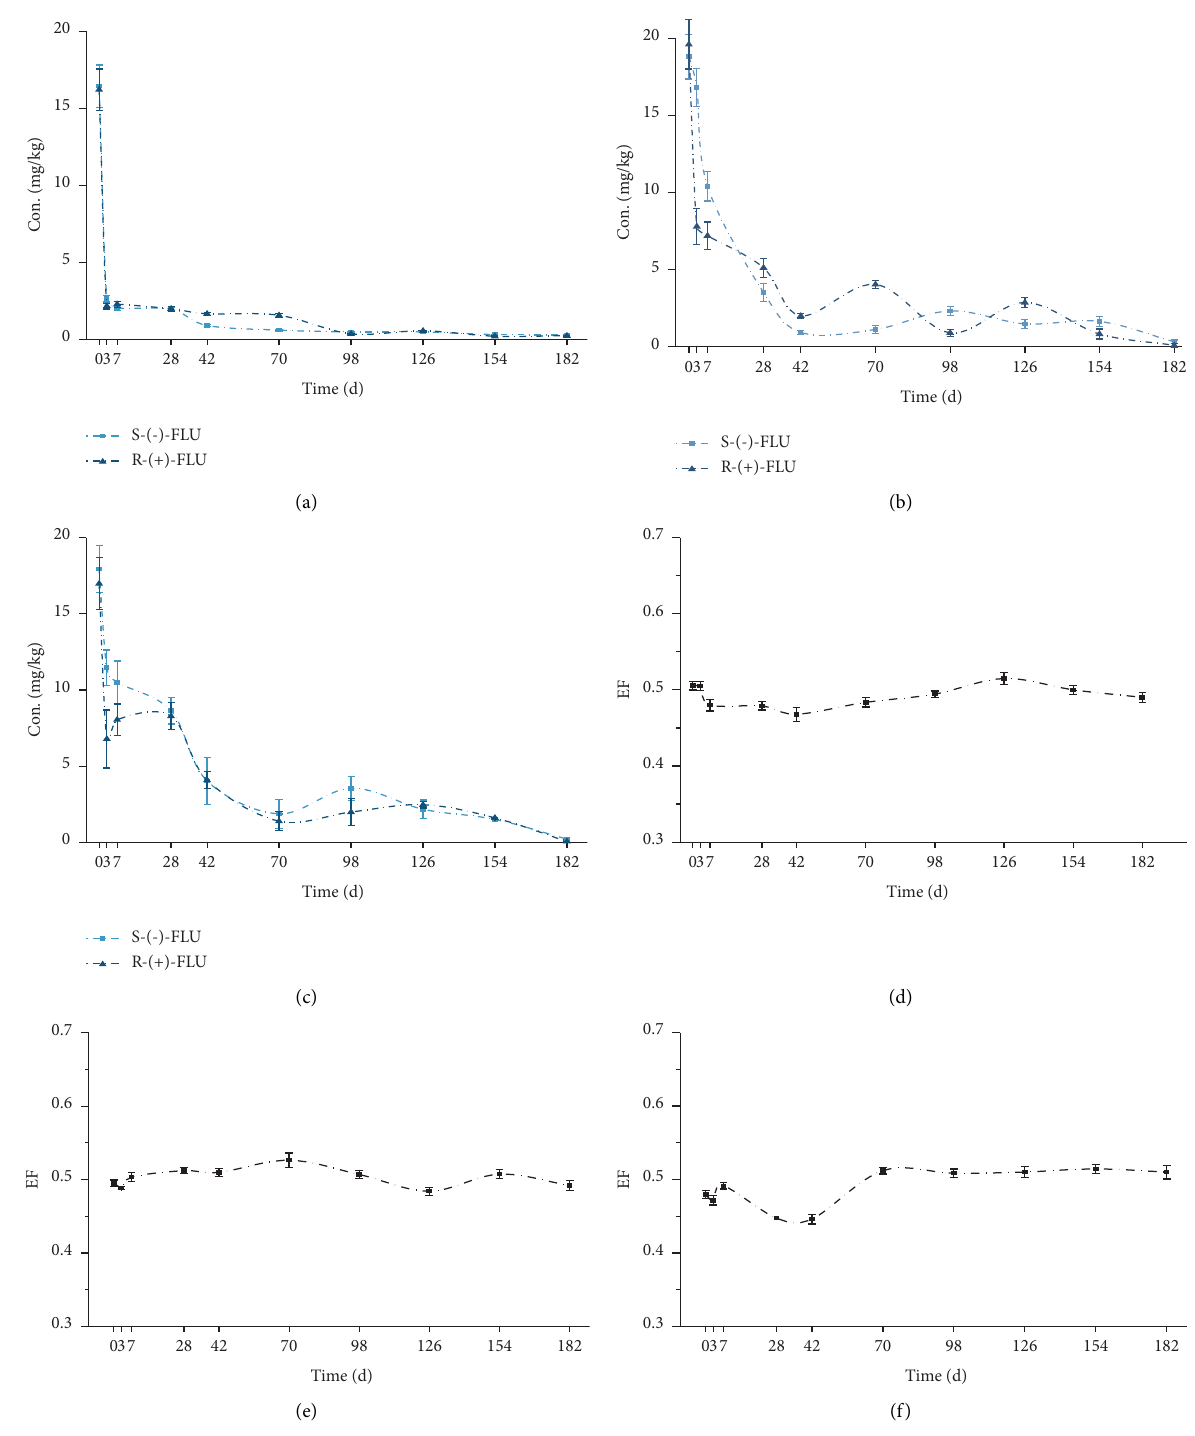
Figure 3: Degradation curves in 1# (a), 2# (b), and 3# (c) and EF variation in 1# (d), 2# (e), and 3# (f) of FLU in the three diferent sediments under sterile conditions. Te points and error bars represent the mean and standard deviation of replicates, respectively ( n �